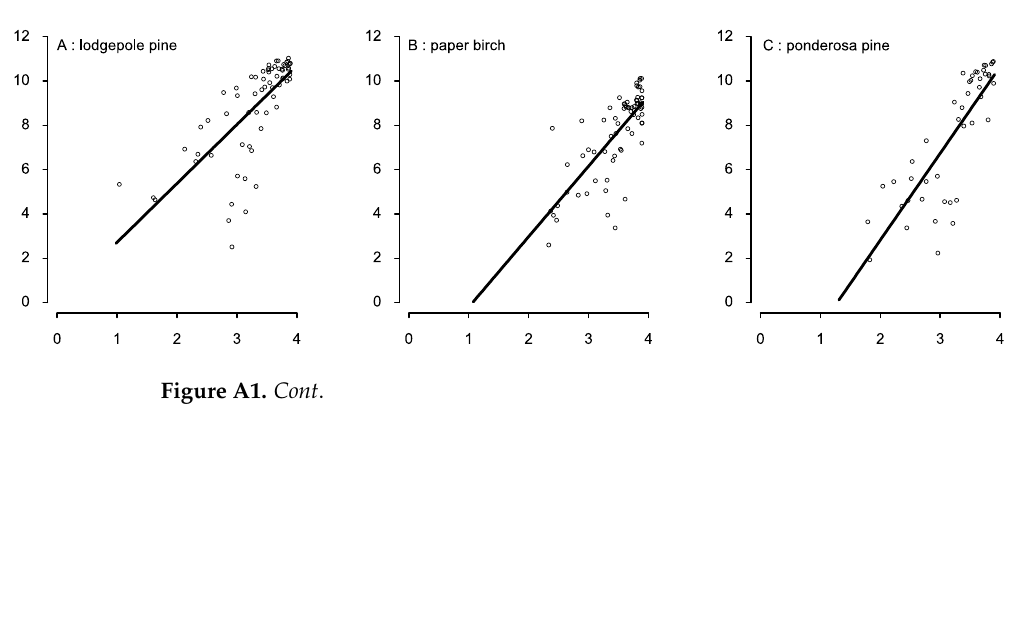
Figure A1. Growth responses of 9 species to the light gradient on a log-log scale. Each point repre- sents individual trees corresponding to Figure 3.